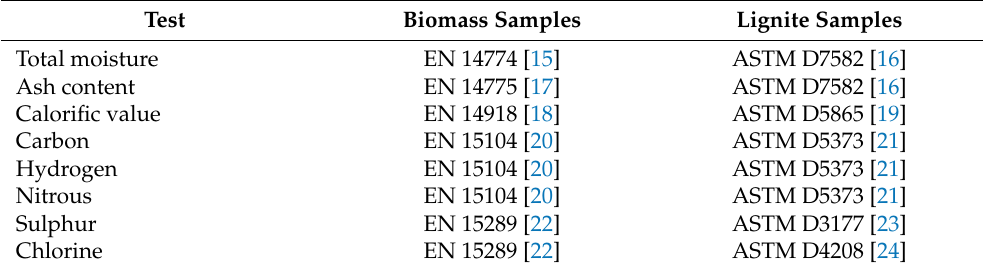
Table 1. Standard analytical methods used for the analysis of the biomass and lignite samples,